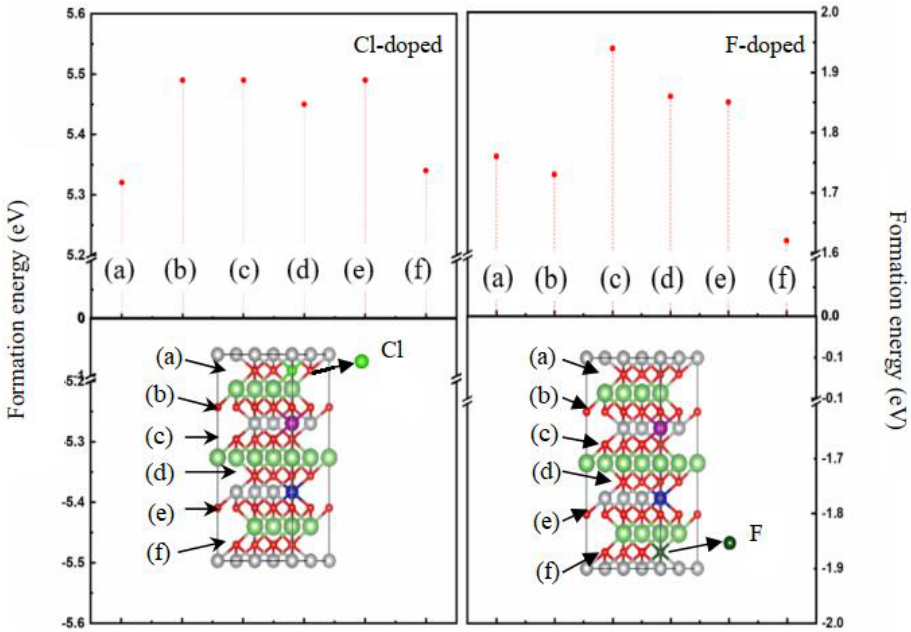
Figure 2. Formation energies of substitution of Cl and F atoms for different O layers.